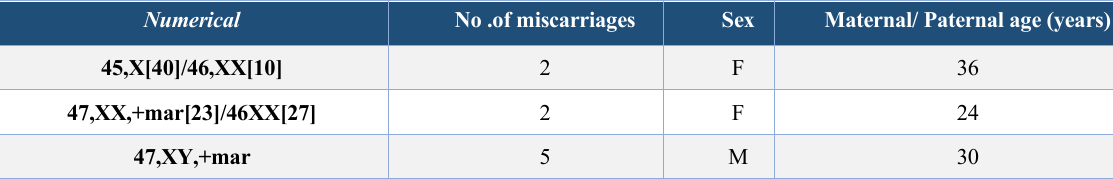
Table 3. Cytogenetic findings, number of miscarriages and maternal/paternal age in recurrent miscarriage cases with numerical chromosomal abnormalities.